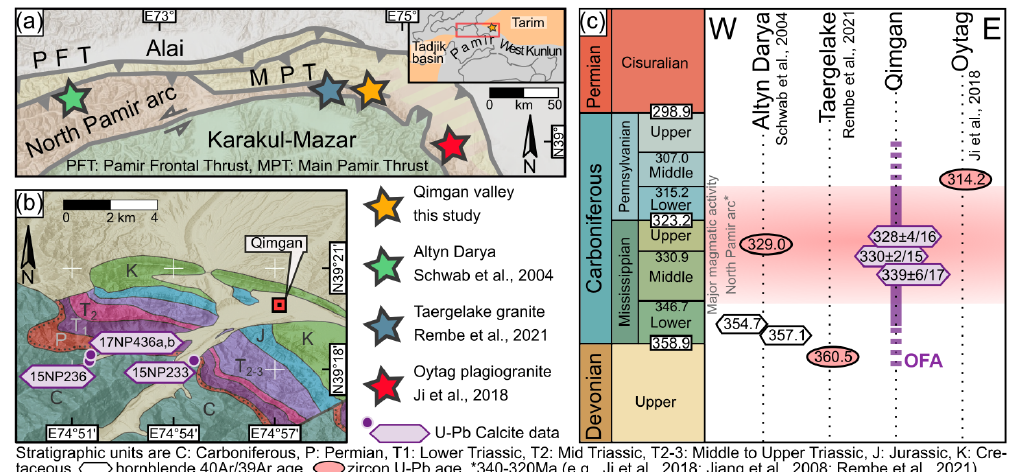
Figure 8. (a) Map of the northeastern Pamir with location of radiometric ages for the North Pamir arc volcanic rocks, shown in (c) . (b) De- tailed field locations of samples in the Qimgan valley (map after Henan Institute of Geological Survey, 2014). There is a sedimentary hiatus between the Middle Pennsylvanian and the Guadalupian (Rembe et al., 2021). (c) Overview of selected literature data and newly obtained data for OFA of the North Pamir Carboniferous arc. Stratigraphic table and ages according to the International Chronostratigraphic Chart (Cohen et al.,